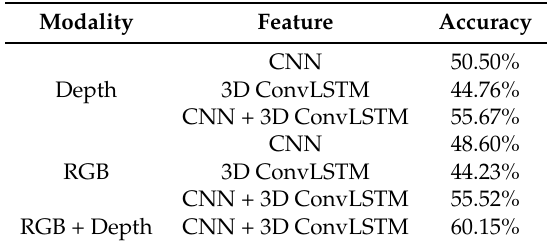
Table 4. Performance on Chalearn LAP IsoGD dataset using the features extracted by the CNN and the 3D ConvLSTM components where “+” indicates average score fusion.